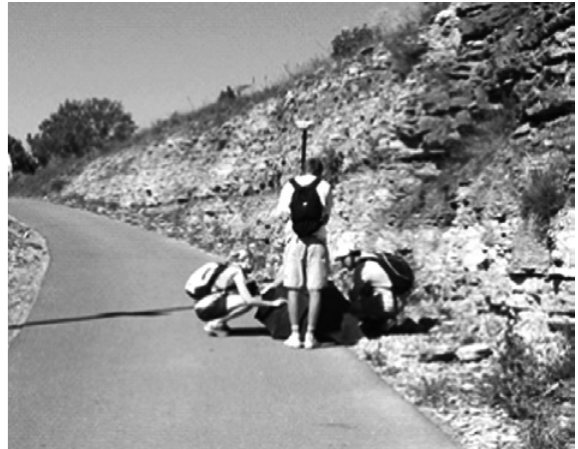
Fig. 4. Gravity surveys on the road that cuts into the North- Estonian Klint (on the background)